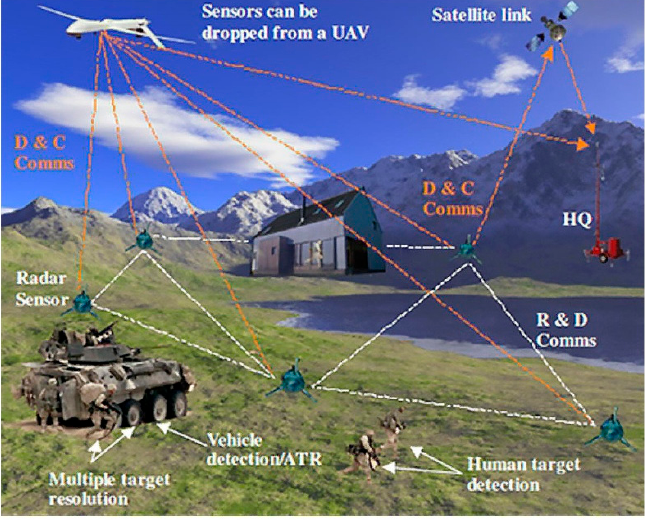
Figure 1. Illustration of netted forward scattering detection. ATR: Automatic Target Recognition; UAV: Unmanned Aerial Vehicle; D & C Comms: Data and Control Communications; R & D Comms: Radar and Data Communications [11].